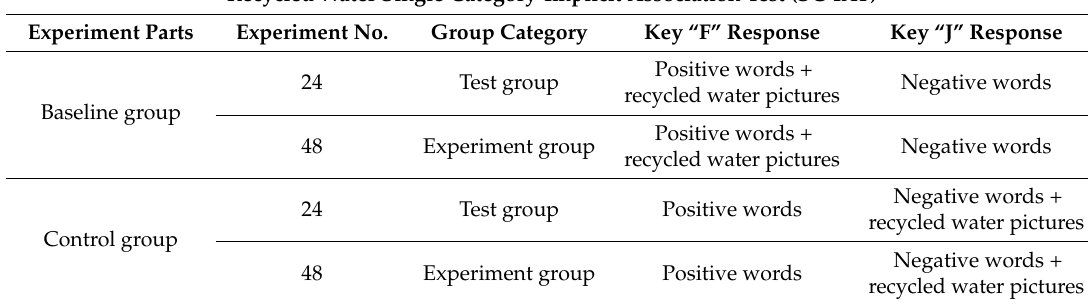
Table 2. Implicit test process of recycled